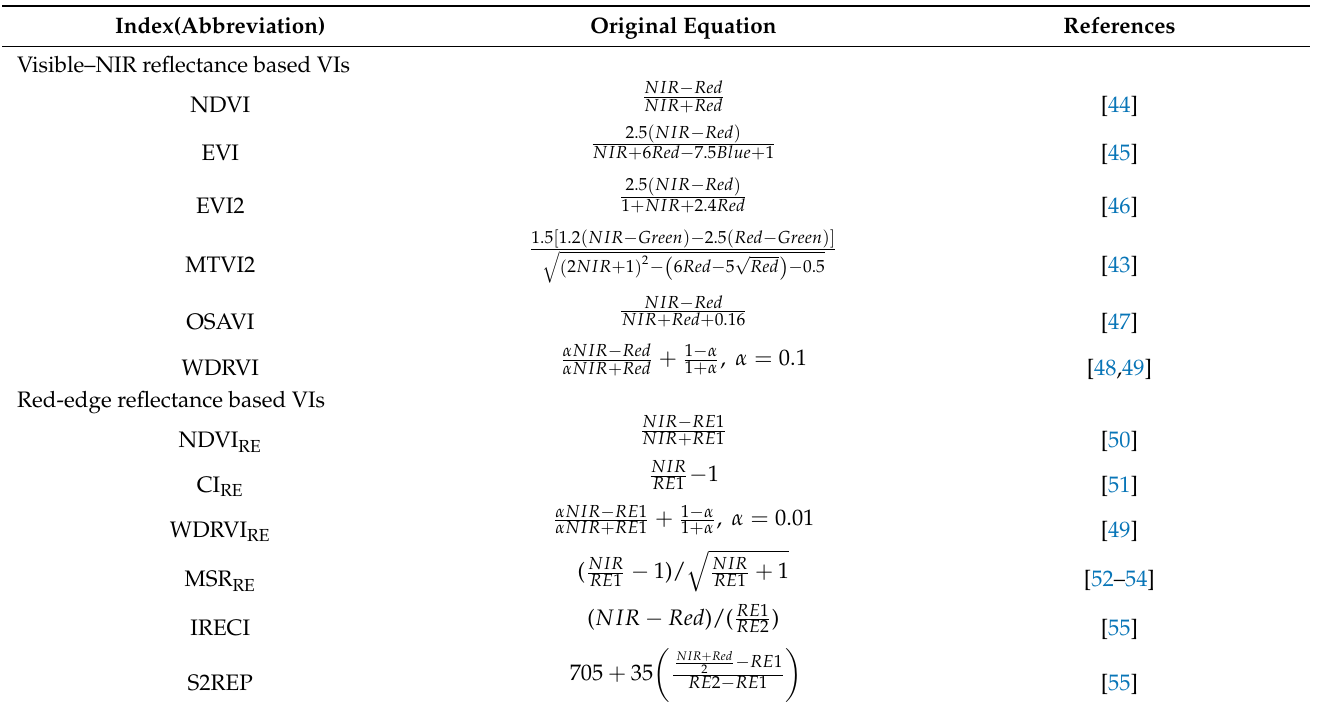
Table 3. Vegetation indices used in this